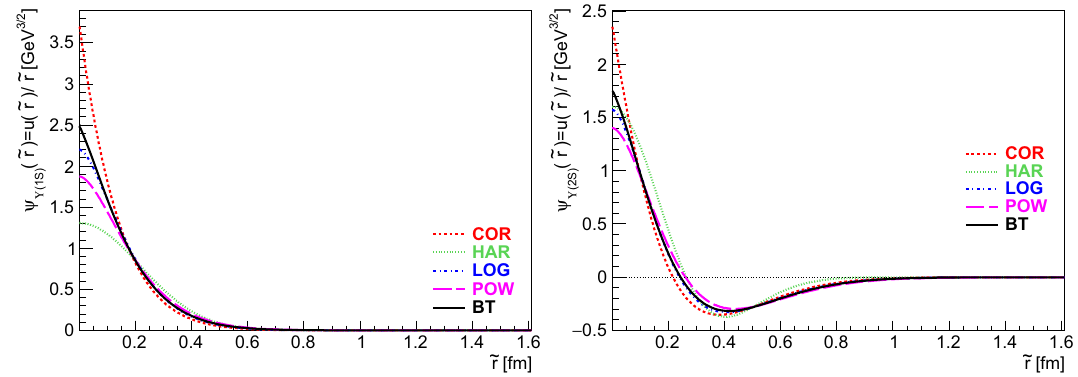
Fig. 28 The radial part of the wave function ψ( ˜ r ) for the J /ψ( 1 S ) (left panel) and ψ (cid:2) ( 2 S ) (right panel) mesons as a solution of the Schrödinger equation for five distinct c − ¯ c interaction potentials described in the Appendix A